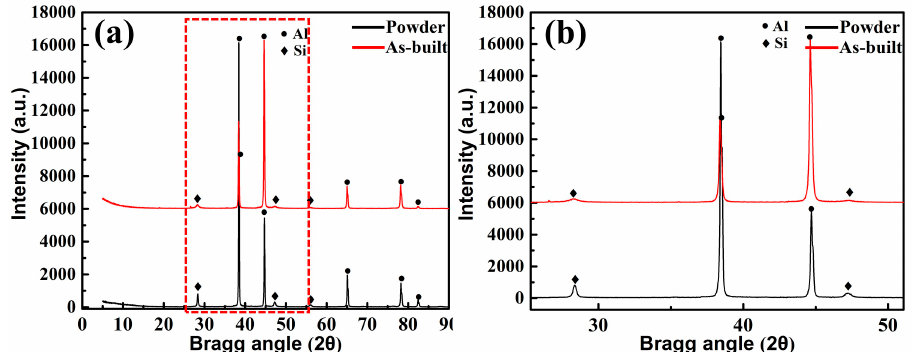
Figure 4. XRD patterns of AlSi10Mg powder and as-built AlSi10Mg alloy branch: ( a ) Complete XRD pattern, ( b ) Magnified XRD pattern of the local area.